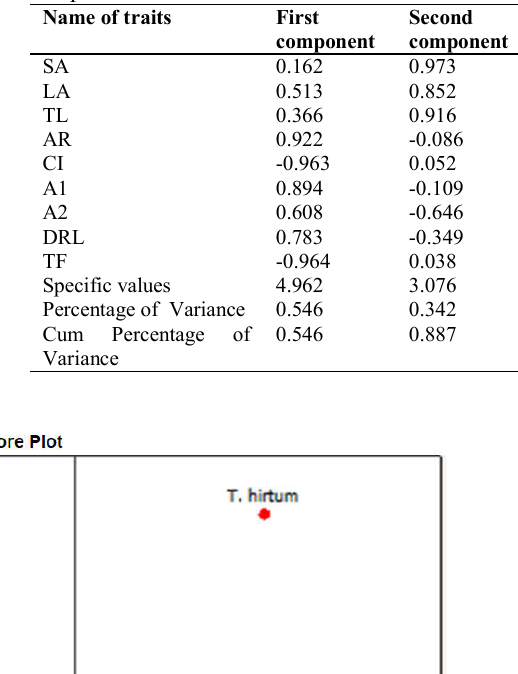
Table 5. Specific values of variance percentage and coefficients of specific vectors in analyzing main